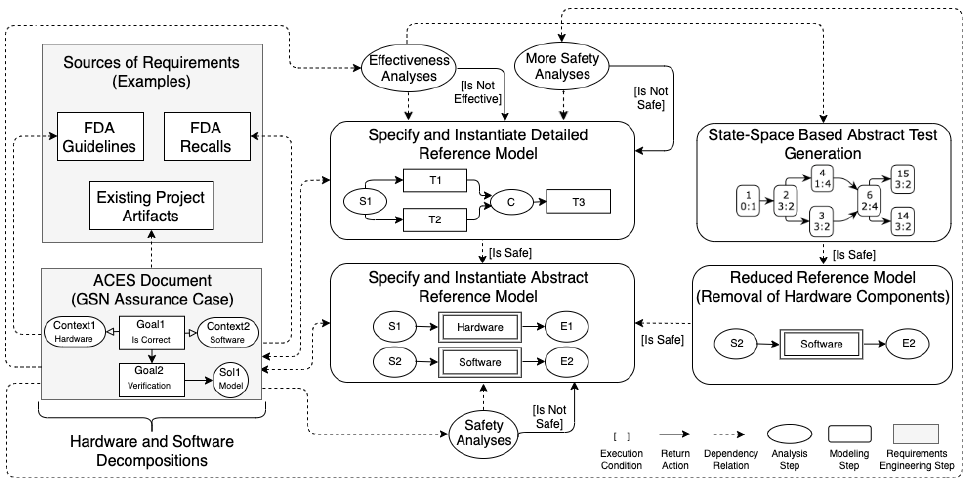
Figure 2. Overview of MBA / CPN for quality assessment of insulin infusion pump